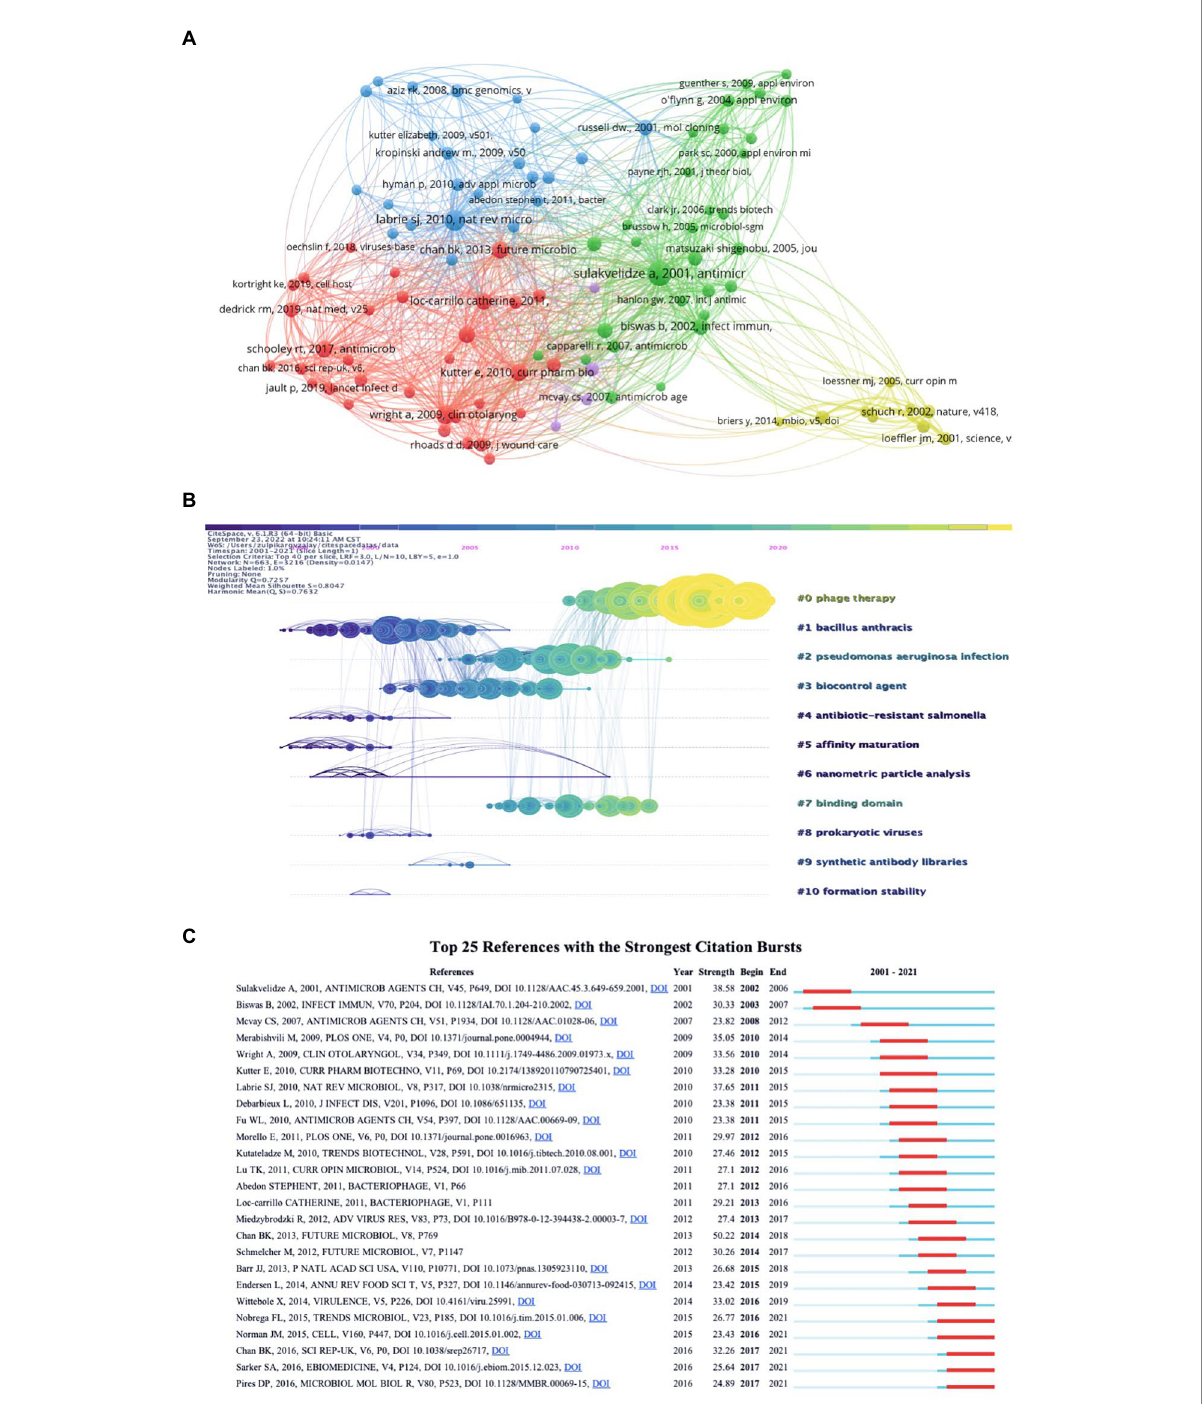
FIGURE 7 Visualization mapping of co-cited references. (A) Network map of co-cited references. (B) Cluster view, top 25 references with strongest citation bursts based on Cite Space. (C) Timeline view, the position of the nodes on the horizontal axis indicates the time when the reference first appeared, the 10 clusters are marked and color coded on the right side, the nodes are large and dense indicating which was the hot topics in that time period, the time evolution is indicated by different colored lines, the more yellow the color indicates closer to